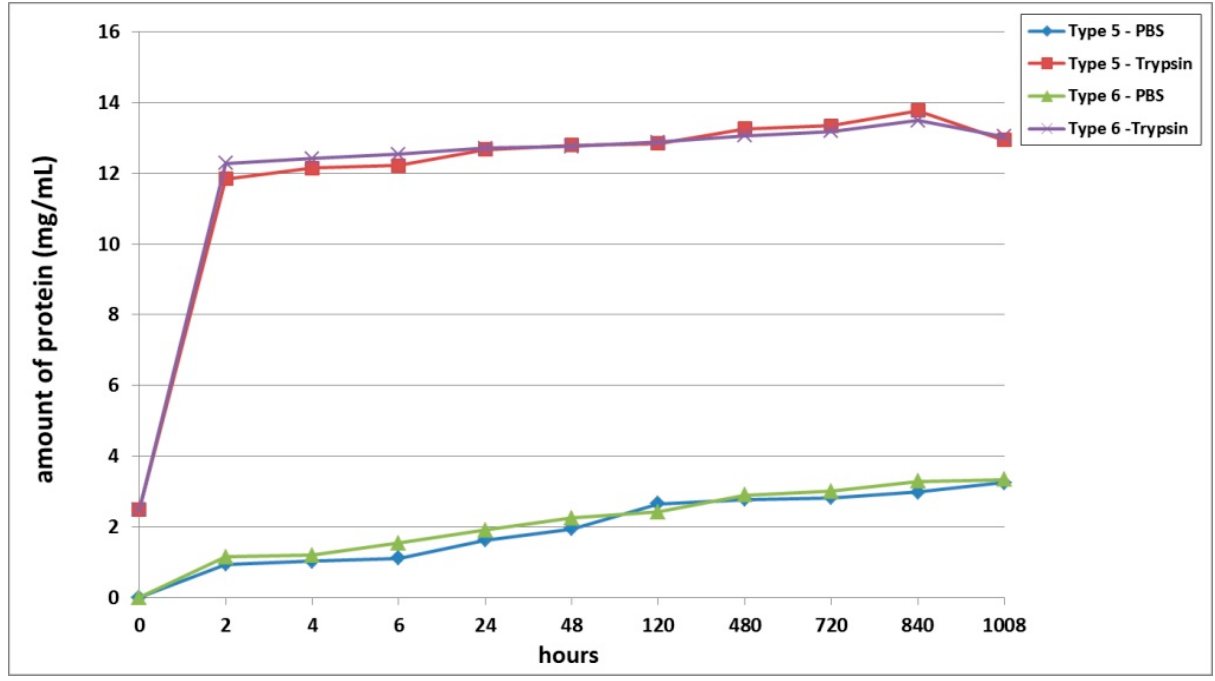
Figure 3. Biodegradation of scaffolds with encapsulated ASCs, pre-cultivated for 6 days before the analysis. Note: PBS— passive biodegradation of scaffolds in PBS solution; Trypsin—enzymatic biodegradation of scaffolds in a solution of the hydrolytic enzyme trypsin.